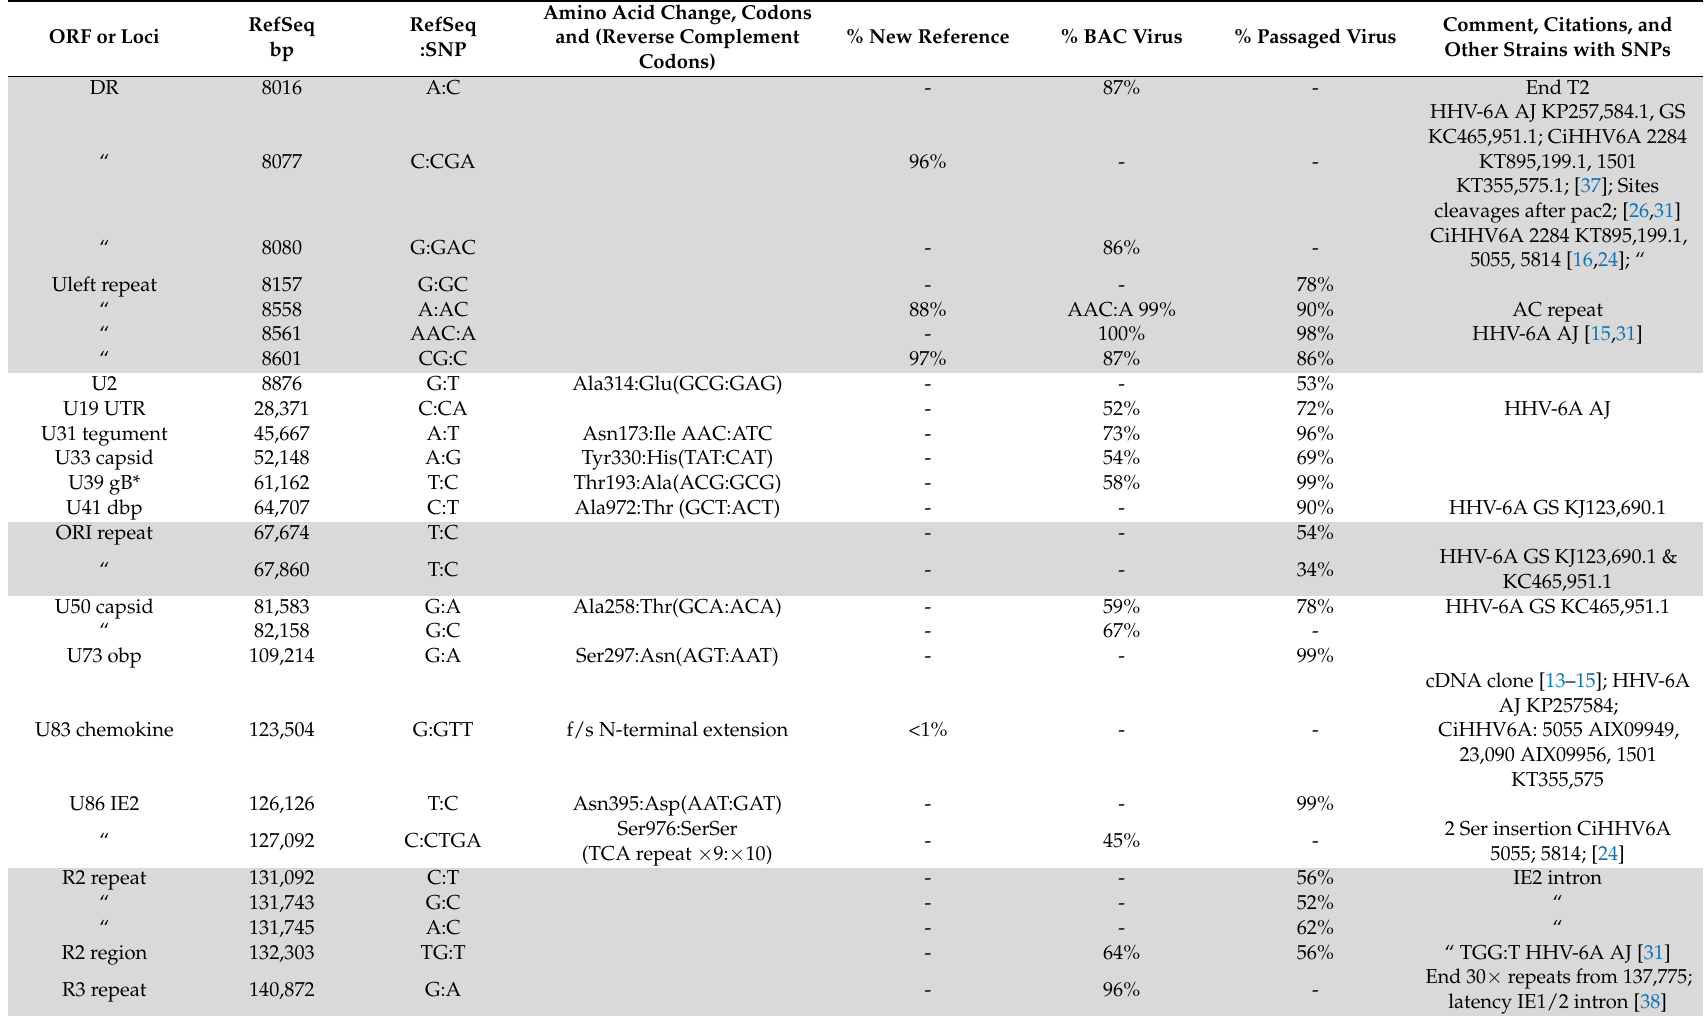
Table 3. Minor variant polymorphism populations in HHV-6A U1102, passaged, and BACmid